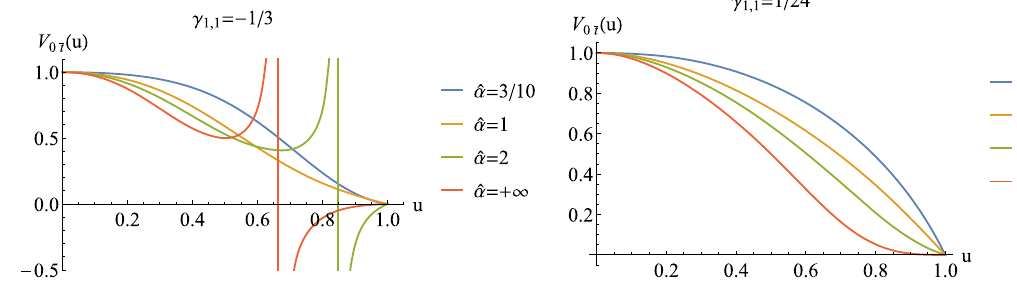
Fig. 24 The potentials V 0 ¯ t ( u ) with representative γ 1 , 1 and ˆ α